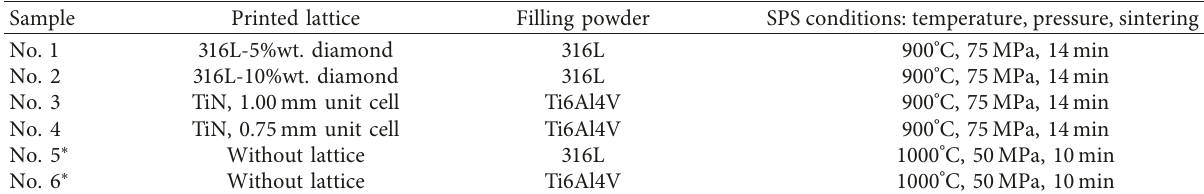
Table 1: Description of samples and SPS conditions.